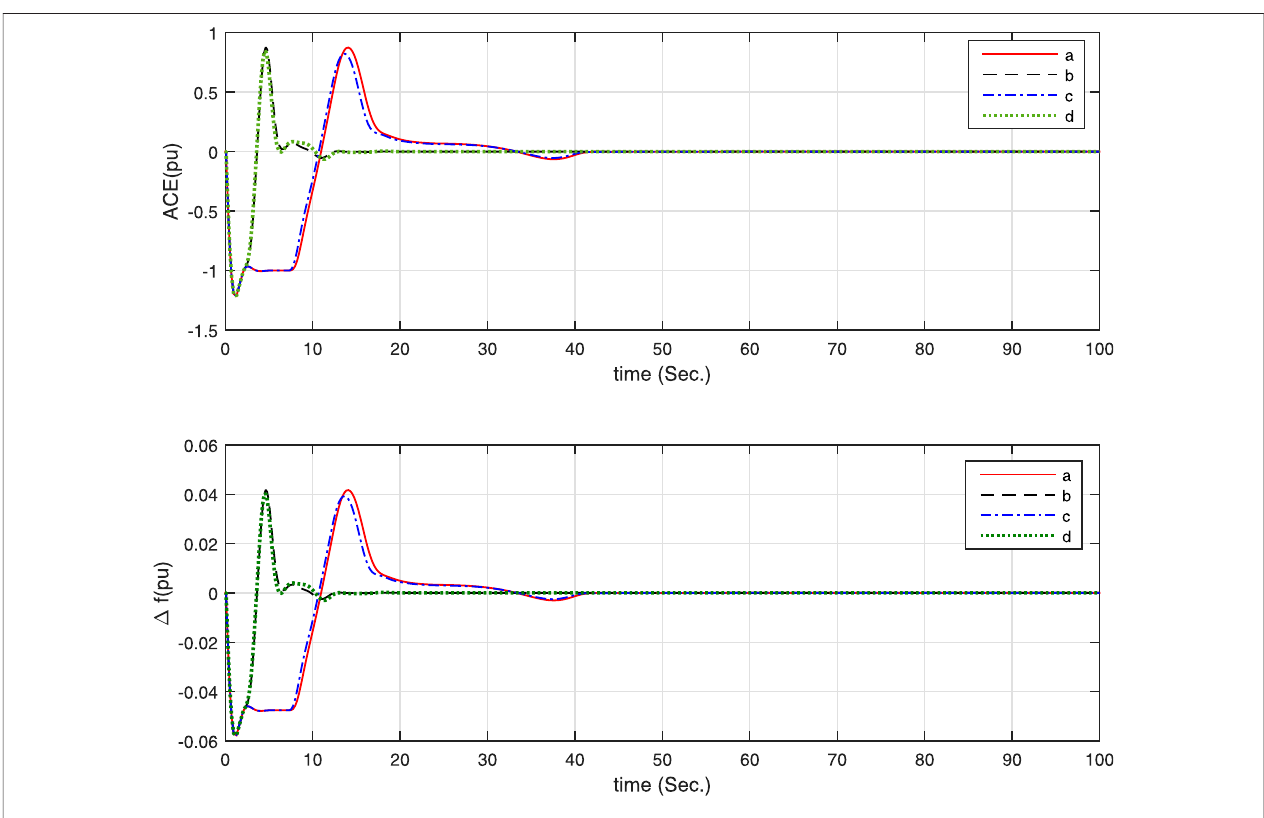
FIGURE 4 | Frequency deviation and control error responses of one-area LFC scheme under μ (cid:2) 0.9.